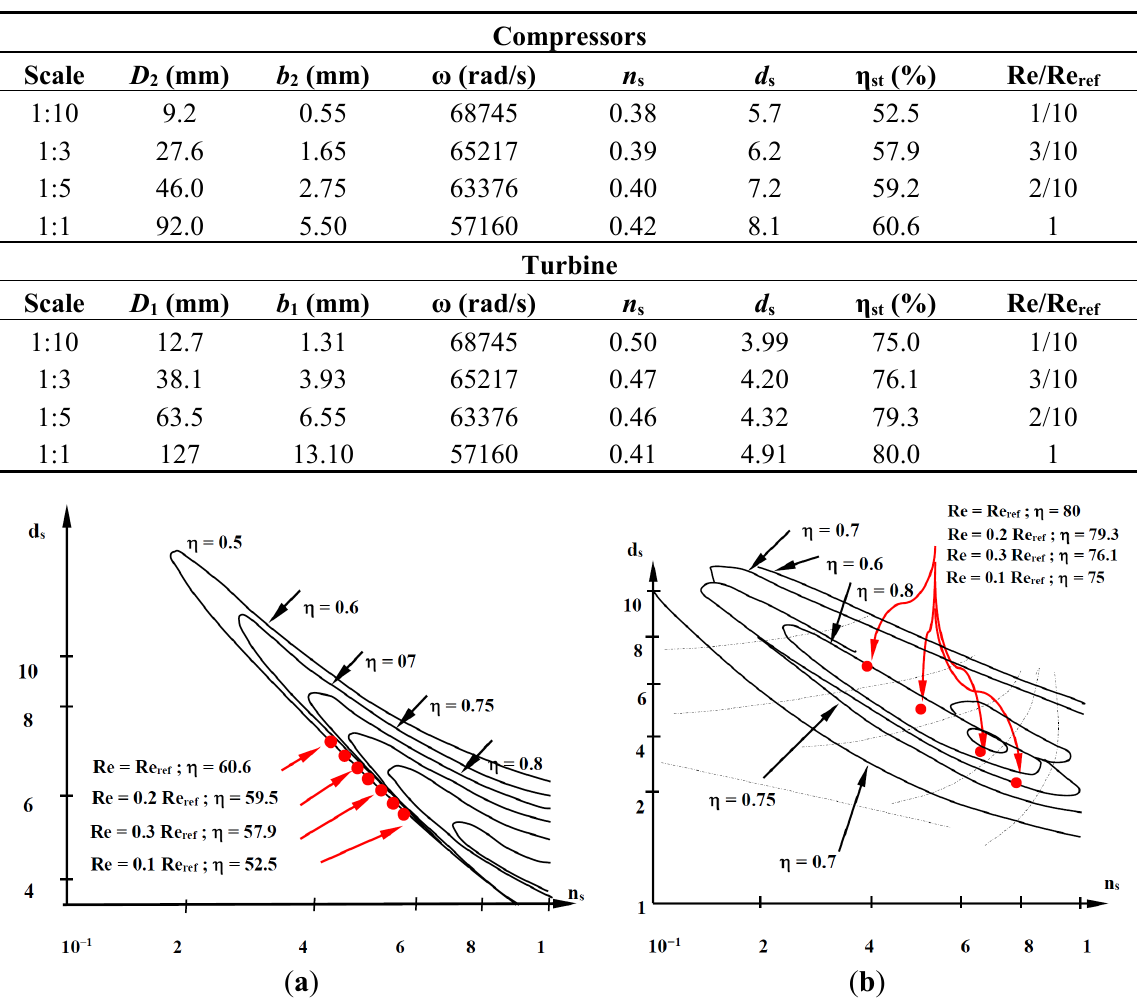
Table 2. Data for different compressor and turbine models (all dimensions in mm).